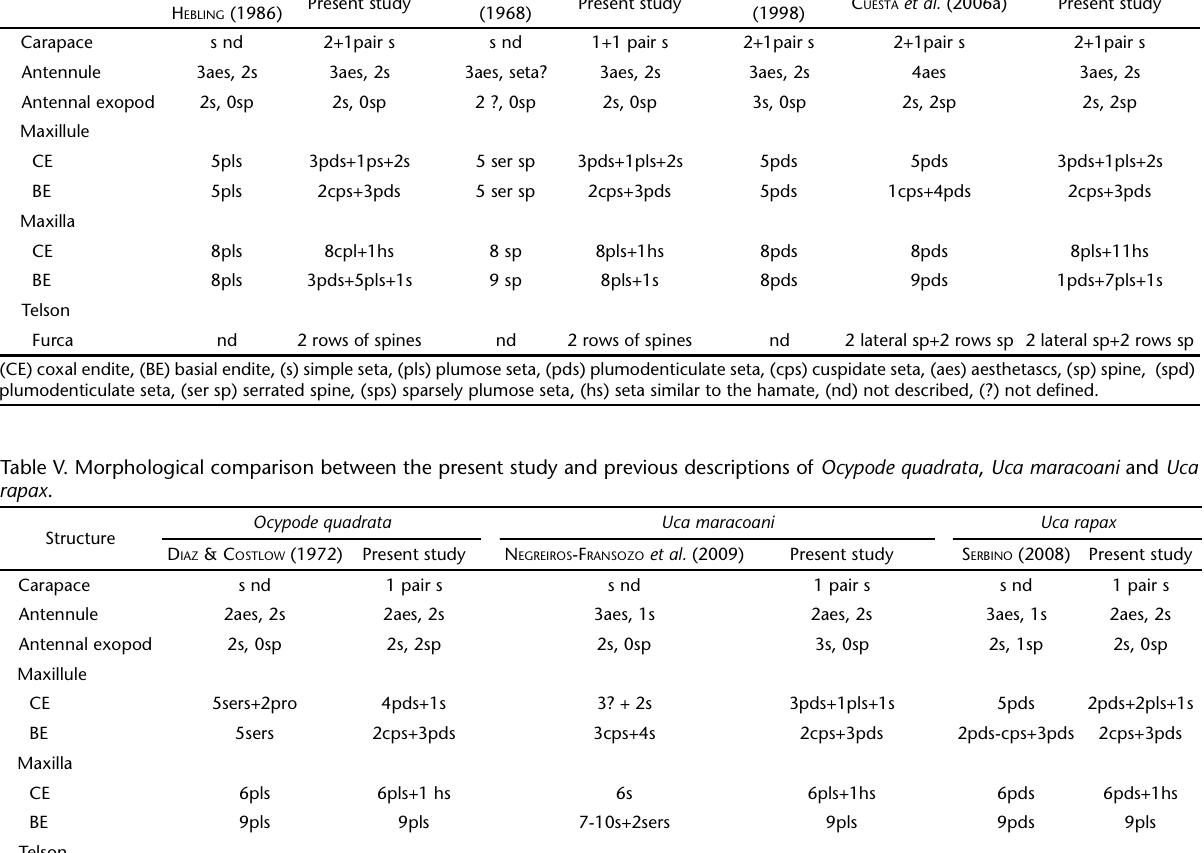
Table IV. Morphological comparison between the present study and previous descriptions of Sesarma rectum , Armases rubripes and Aratus pisonii . Structure